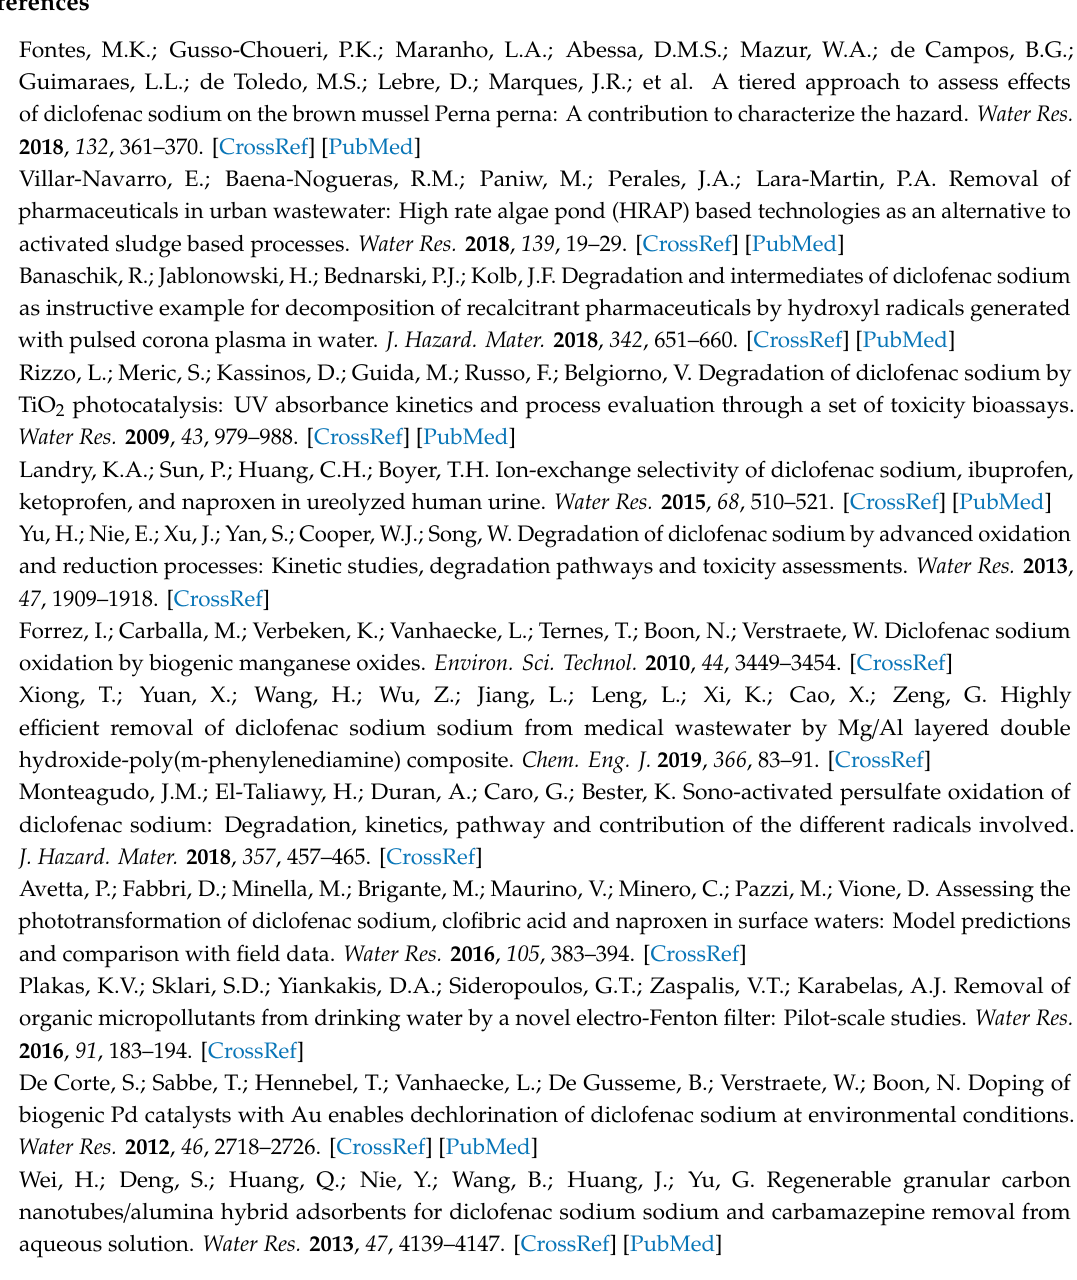
Table S2: Variance analysis of regression model; Figure S1: C1s XPS spectra peak fitting of TAPAM-PDA-Fe 3 O 4 (A),